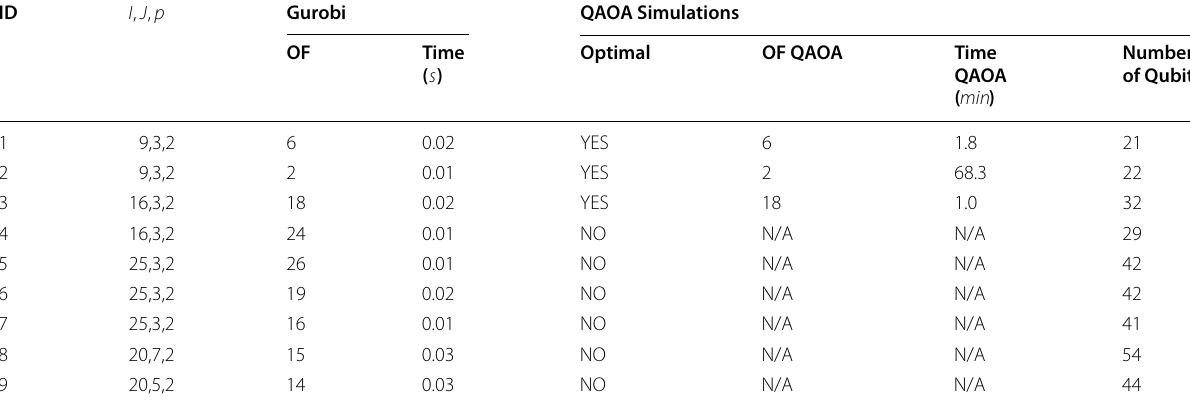
Table 6 Summary of QAOA